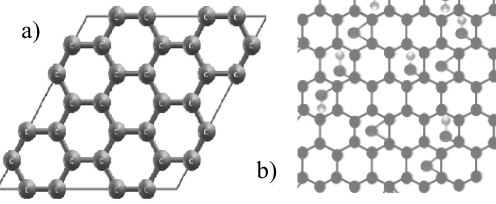
Fig. 1. Typical graphene layer (a) and graphene oxide layer containing different functional groups